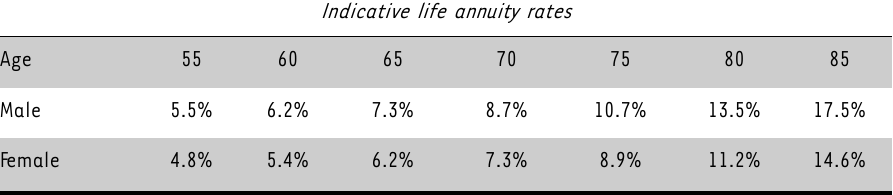
TABLE 1: Indicative life annuity